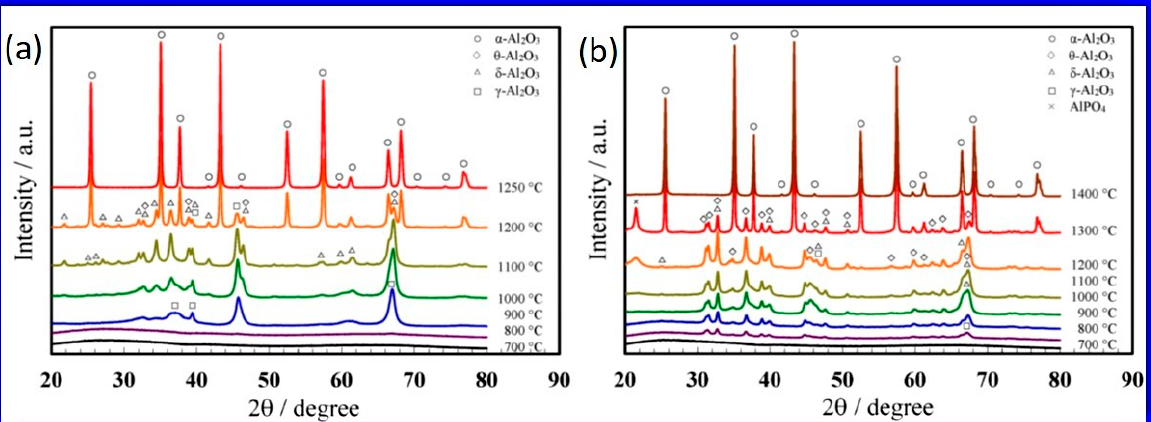
Figure 5. X-ray diffractograms of NAA, prepared in ( a ) oxalic acid at 40 V and ( b ) phosphoric acid at 185 V, showing various phase transformations with heat treatment at elevated temperatures. Reproduced with permission from Tatsuya Masuda, Hidetaka Asoh, Satoshi Haraguchi, and Sachiko Ono, Materials 8 (3), 1350 (2015)